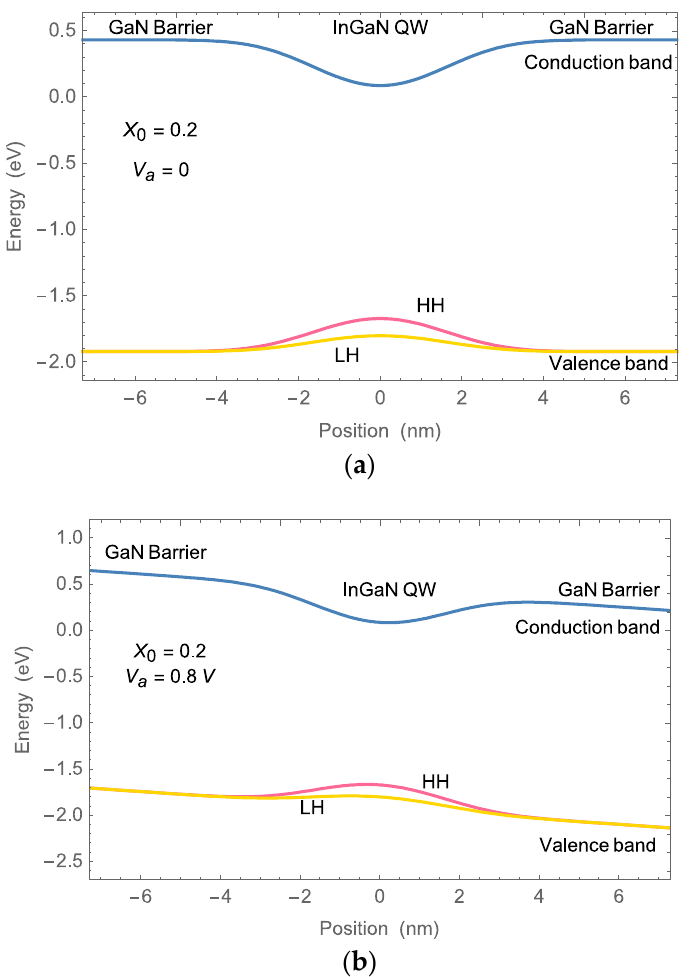
Figure 2. Schematic diagram of the In x Ga 1-x N/GaN parabolic MQW LED structures at an applied bias of ( a ) 0 V and ( b ) 0.8 V.